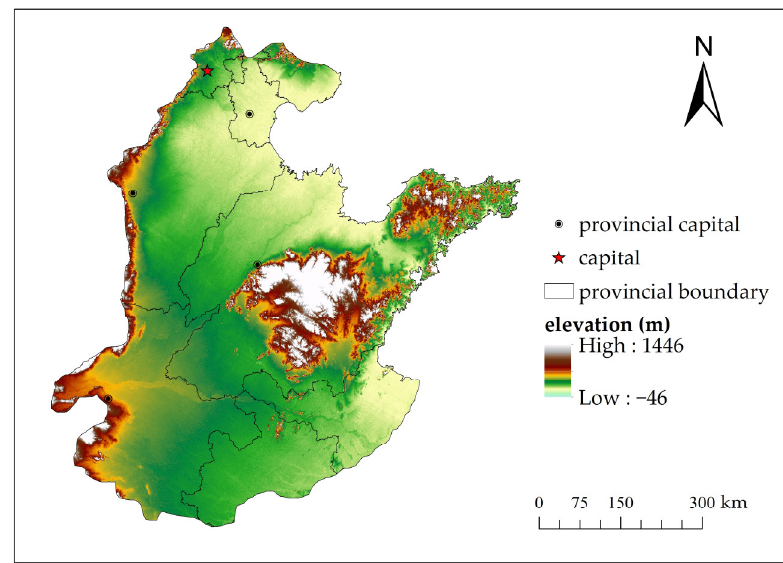
Figure 2. Elevation in the HHHP.